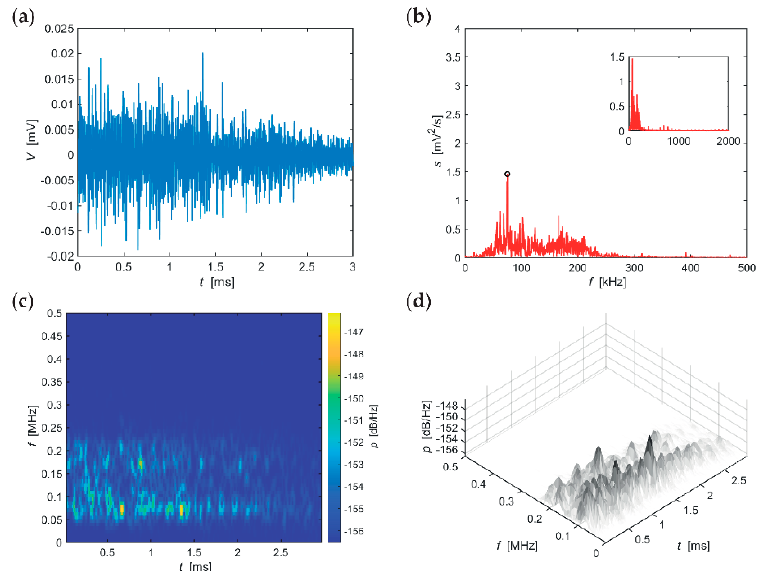
Figure 10. Visualisation of the recorded AE signal during 75–100 F-T cycles from specimens CS150: ( a ) time course of the amplitude, ( b ) frequency spectrum, ( c ) spectrogram STFT-2D image, ( d ) spectrogram STFT-3D image.